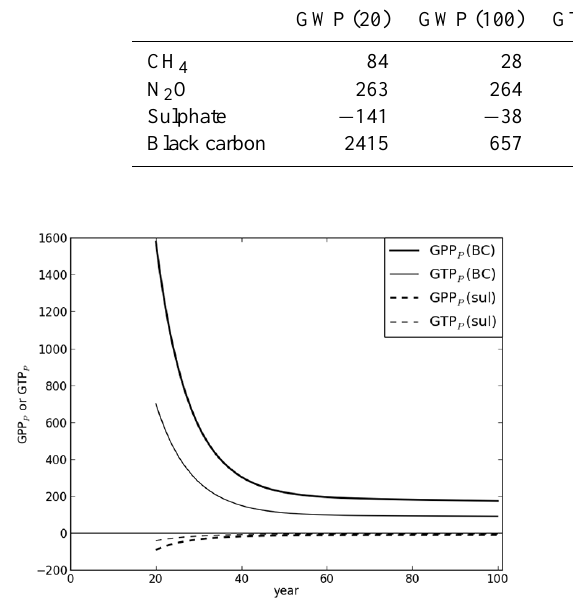
Figure 6. GPP S (in bold) and GTP S for 1kgyr − 1 sustained emis- sions of BC and sulphate relative to a 1kgyr − 1 sustained emission of CO 2